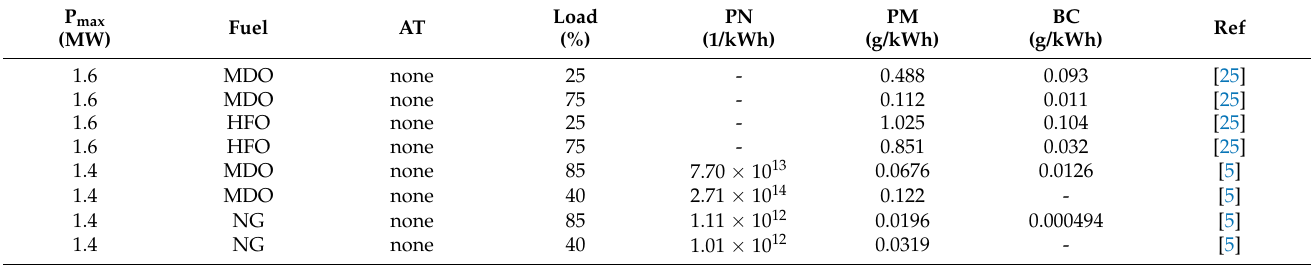
Table A2. Emissions per energy values from previous studies. P max refers to engine maximum power and AT to aftertreatment. Reference (Ref) is given for results from the